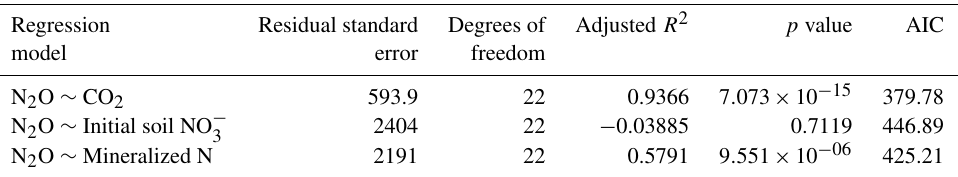
Table 7. Results of regression analyses of the relationship between total cumulative N 2 O emissions, total cumulative CO 2 emissions, and N parameters of plant litter and soil (AIC: Akaike’s information